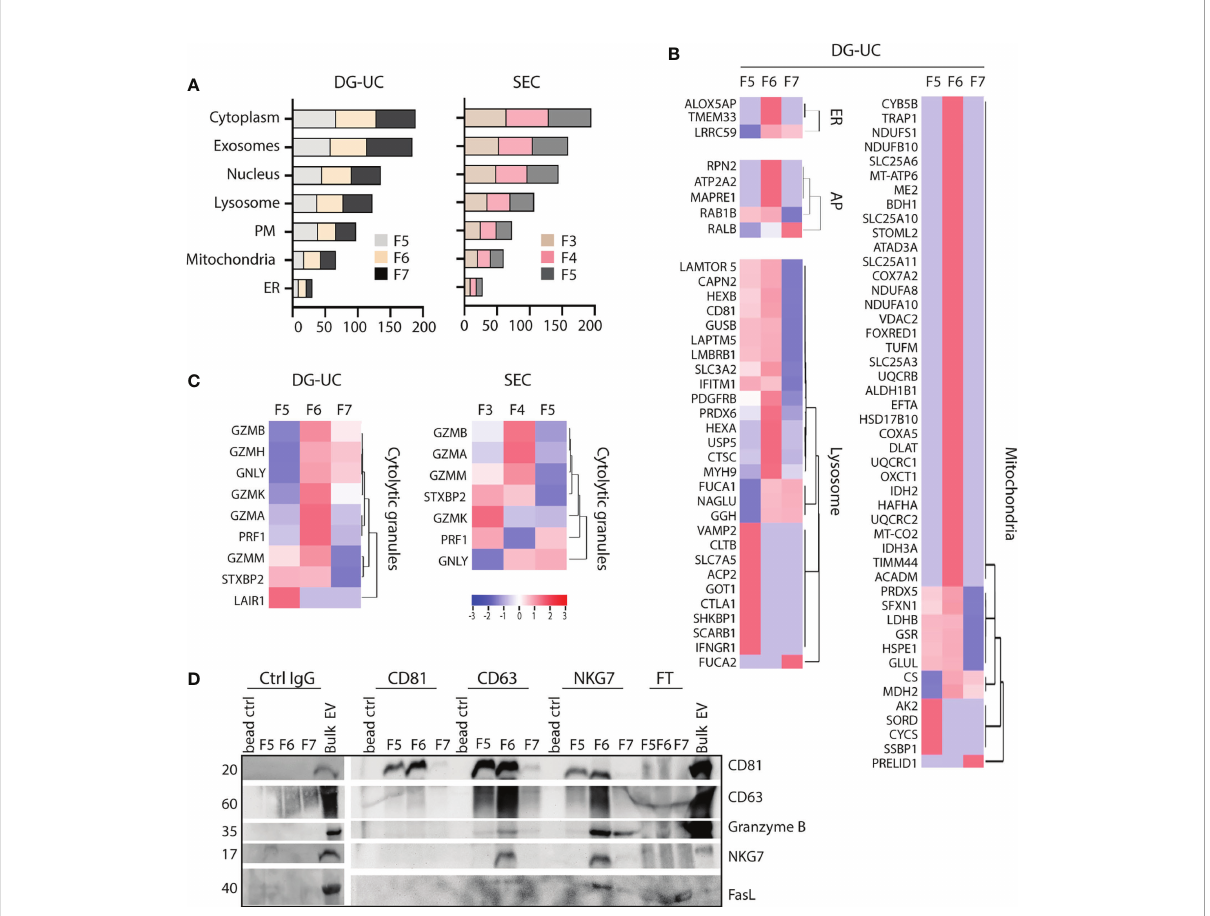
FIGURE 4 Identi fi cation of organelle speci fi c signatures within DG-UC subpopulations. (A) FunRich cellular component analysis of proteins identi fi ed DG- UC fractions 5-7 or SEC fractions 3-5, showing percentage enrichment of proteins. (B) Heatmaps representing 3 three biological replicates of DG-UC fractions 5-7, represented by log2 mean intensity values of mitochondria, endoplasmic reticulum (ER), autophagosome (AP), and lysosome. Markers were identi fi ed through matching against the UniProt subcellular localization database. (C) Heatmaps representing three biological replicates of DG-UC fractions 5-7 or SEC fractions 3-5, represented by log2 mean intensity values of cytolytic granule markers identi fi ed through matching against the UniProt subcellular localization database. (D) Representative western blot analysis of sequential immunoprecipitations of DG-UC fractions 5-7 with controls IgG mAb, followed by antibodies against CD81, CD63 and NKG7. EVs from NK-92 cells were used as positive control. FT, fl ow-through; remaining sample after indicated